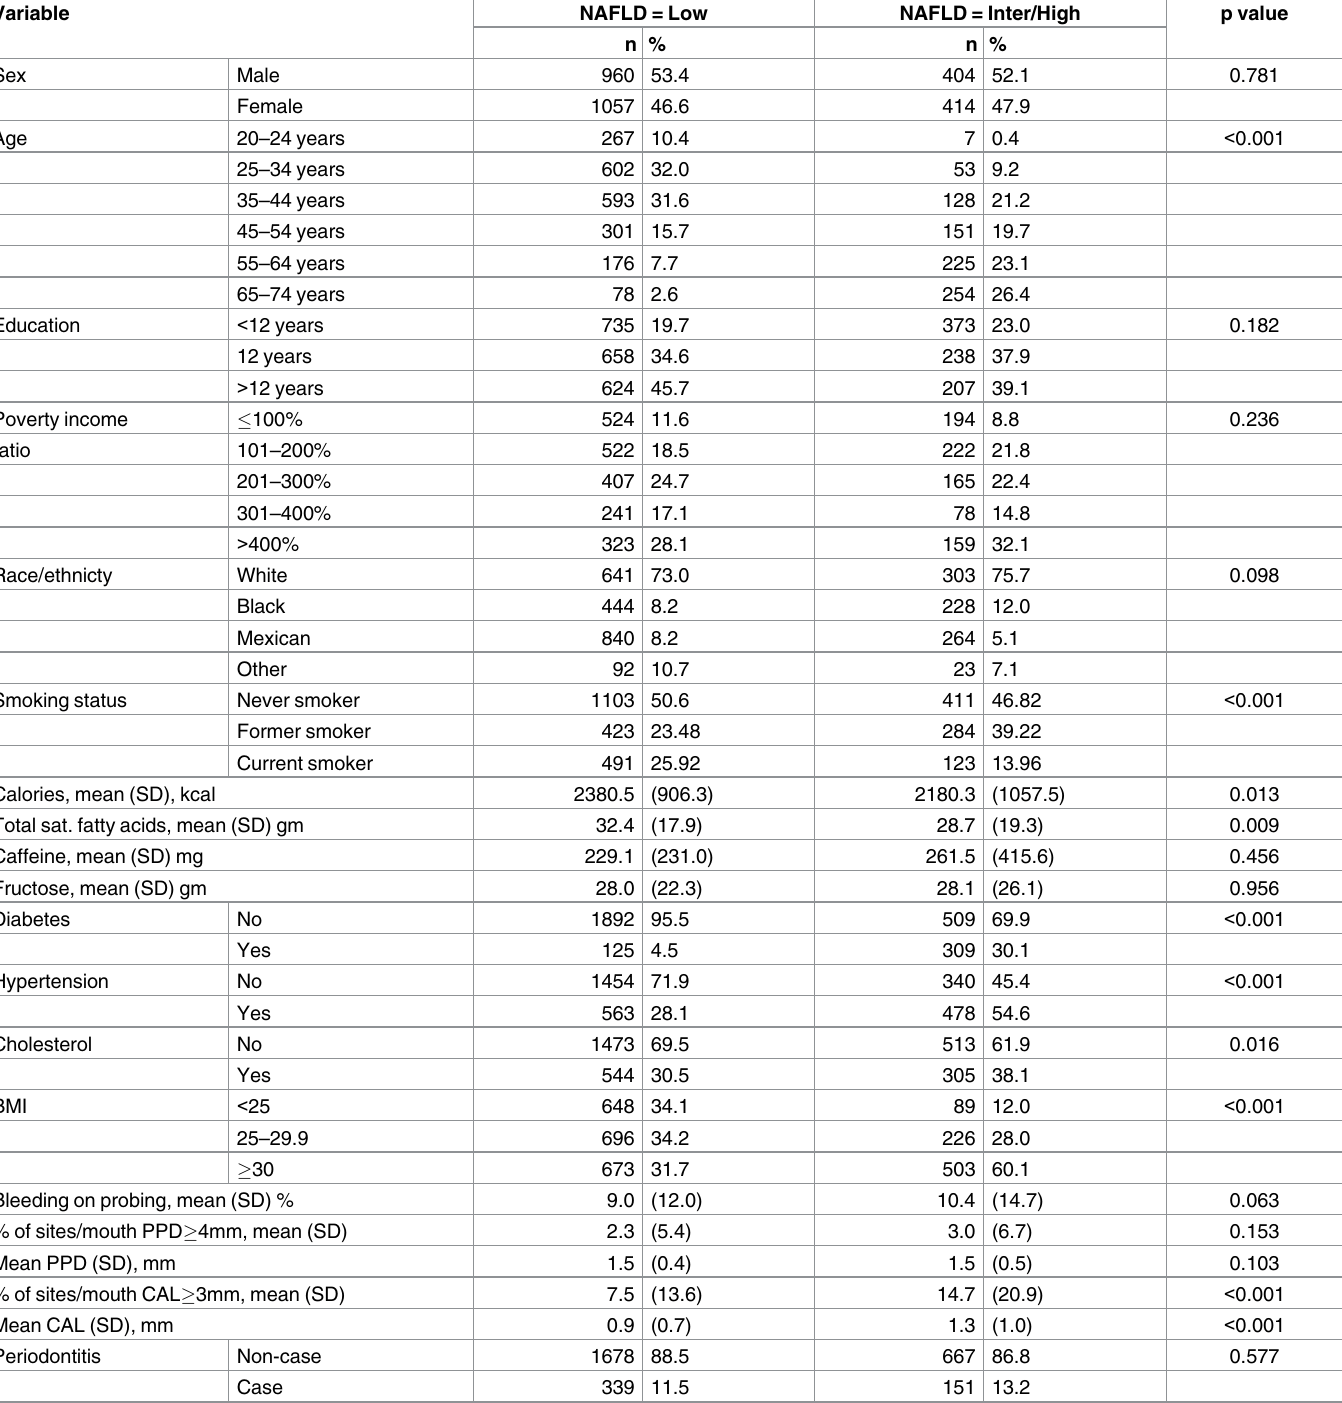
Table 3. Characteristics of respondents in NHANES III with steatosis on ultrasound and low risk versus indeterminate / high risk scores by NAFLD fibrosis score (NFS, n = 2835).